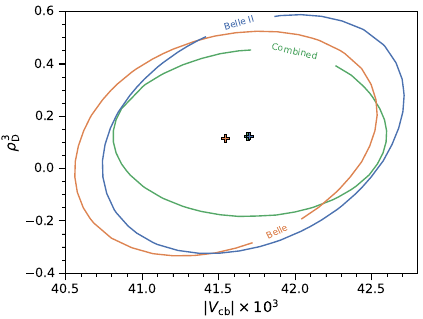
Figure 5 . Comparison between Belle, Belle II and the combined fit for the correlation between . The crosses indicate the best-fit | V cb | and ρ 3 D